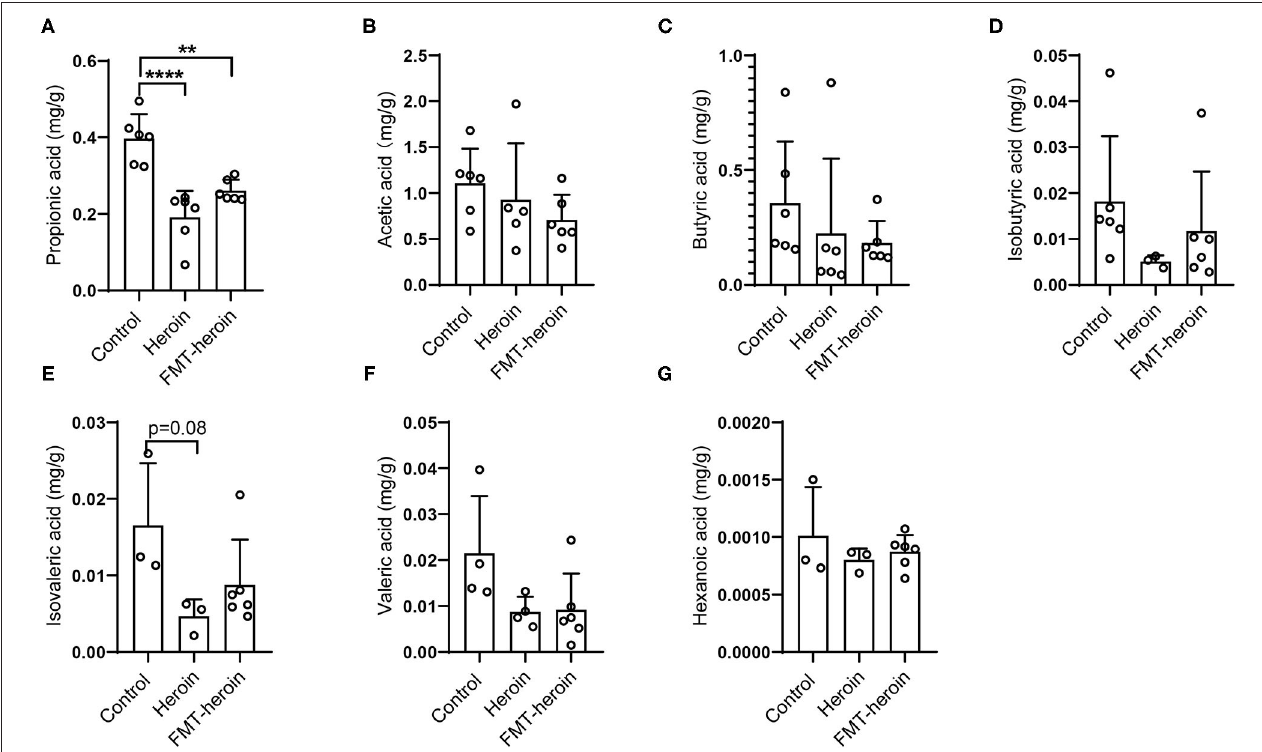
FIGURE 6 | Composition of short chain fatty acids in fecal samples of control, heroin-administrated and FMT treated mice. The levels of propionic acid were significantly altered in the heroin and FMT groups (A) . (B–G) Concentrations of the major SCFAs acetate, butyrate, isovaleric, isobutyric, valeric, hexanoic. All data are expressed as the mean ± SD ( n = 6 per group). Statistically differences were analyzed with one-way ANOVA, ** p < 0.01; **** p <